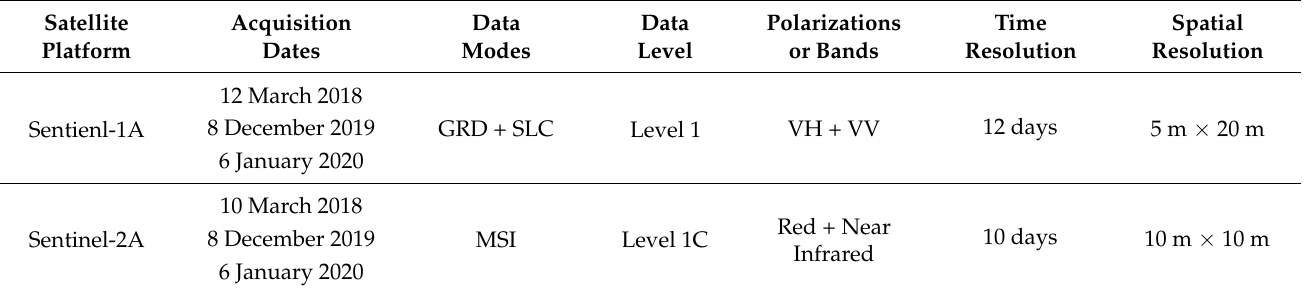
Table 2. Characteristics of Sentinel-1 and Sentinel-2 data used in this